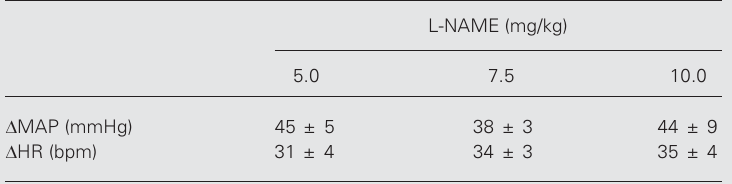
Table 1. Effects of increasing doses of L-NAME on changes in mean arterial pressure ( (cid:1) MAP) and heart rate ( (cid:1) HR) after complete autonomic blockade.